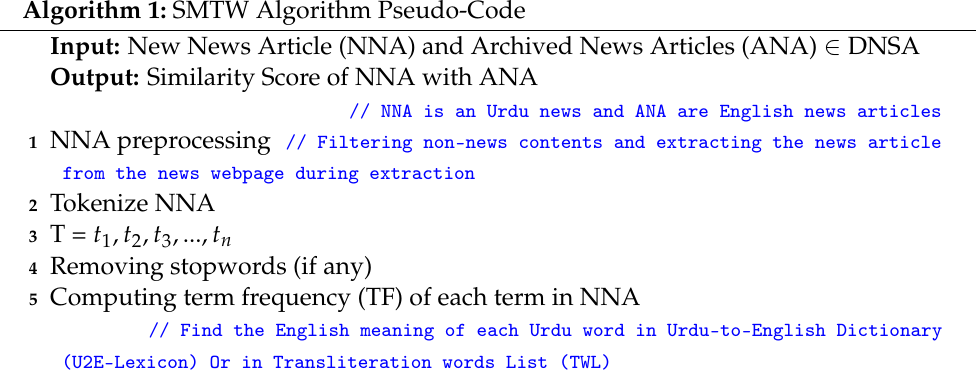
Algorithm 1: SMTW Algorithm